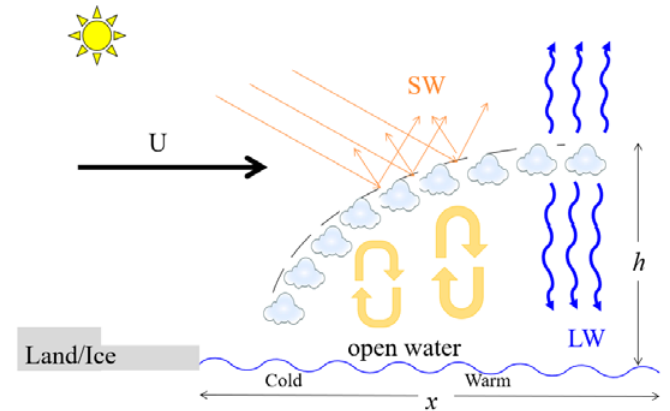
Figure 26. A schematic diagram to illustrate interactions between cold air and warmer water in producing a rising boundary-layer top over open water during the CAO event.